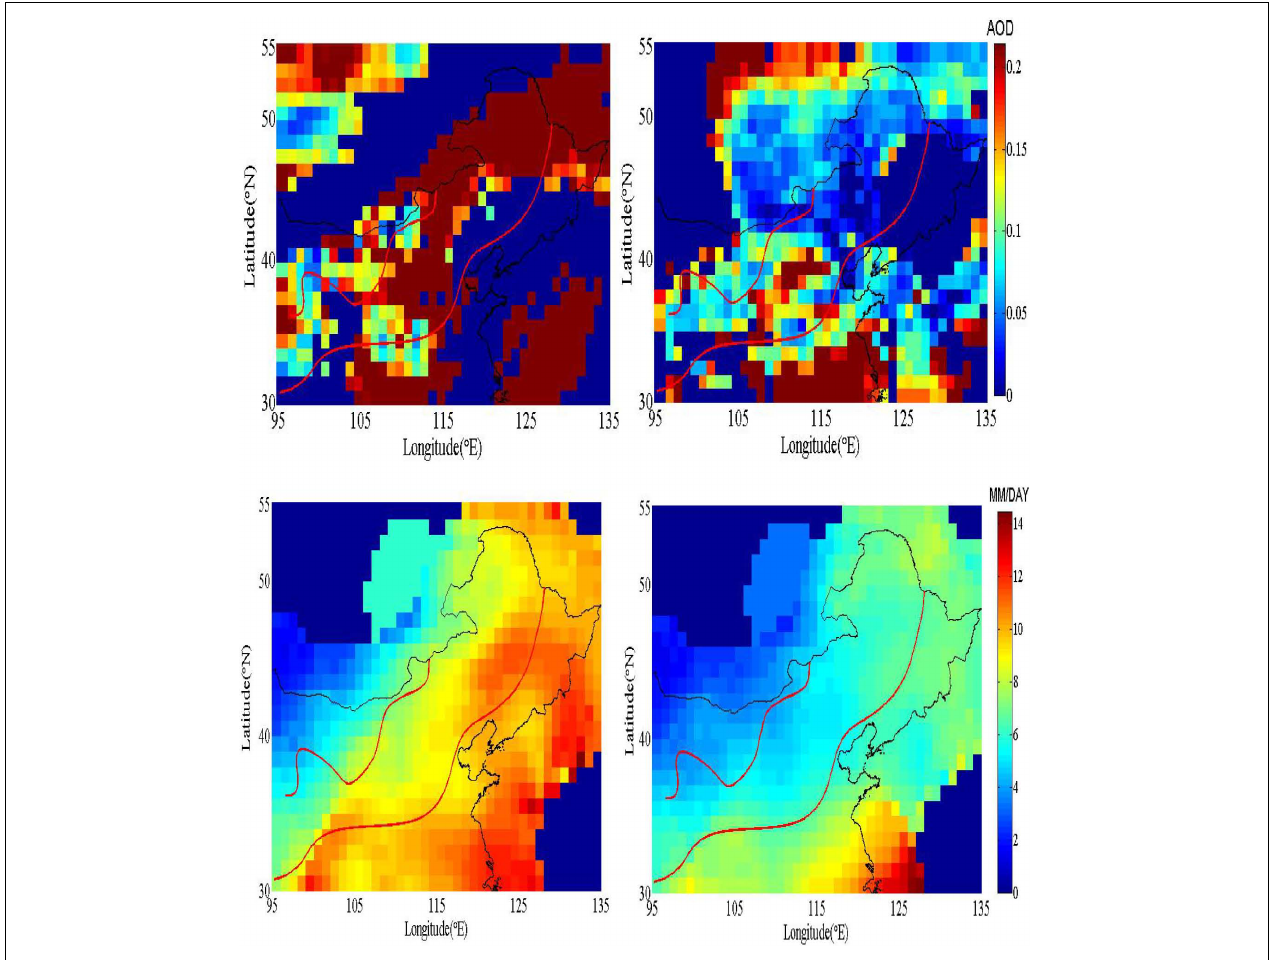
FIGURE 3 | Aerosol optical depth (AOD) and precipitation over the transition zone in abundant and deficient years ( Left : abundant years; Right : deficient